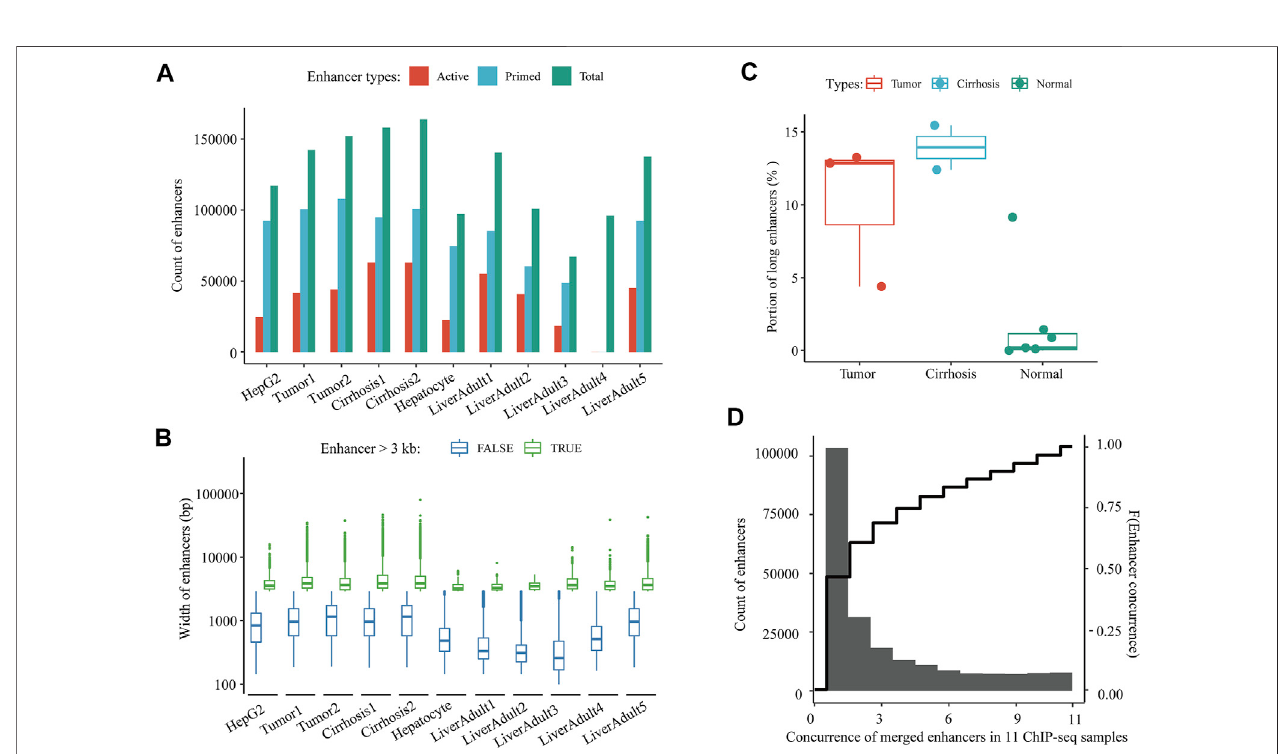
FIGURE 2 | A comprehensive catalog of enhancers in the liver. (A) Count of active and primed enhancers in each liver-relevant ChIP-seq sample. (B) Length distributionofenhancersineachliver-relevantChIP-seqsample. (C) Proportionsoflongenhancersinthreetypesofliver-relevantChIP-seqsamples.And (D) Distribution of the concurrence of all merged enhancers among 11 liver-relevant ChIP-seq samples.